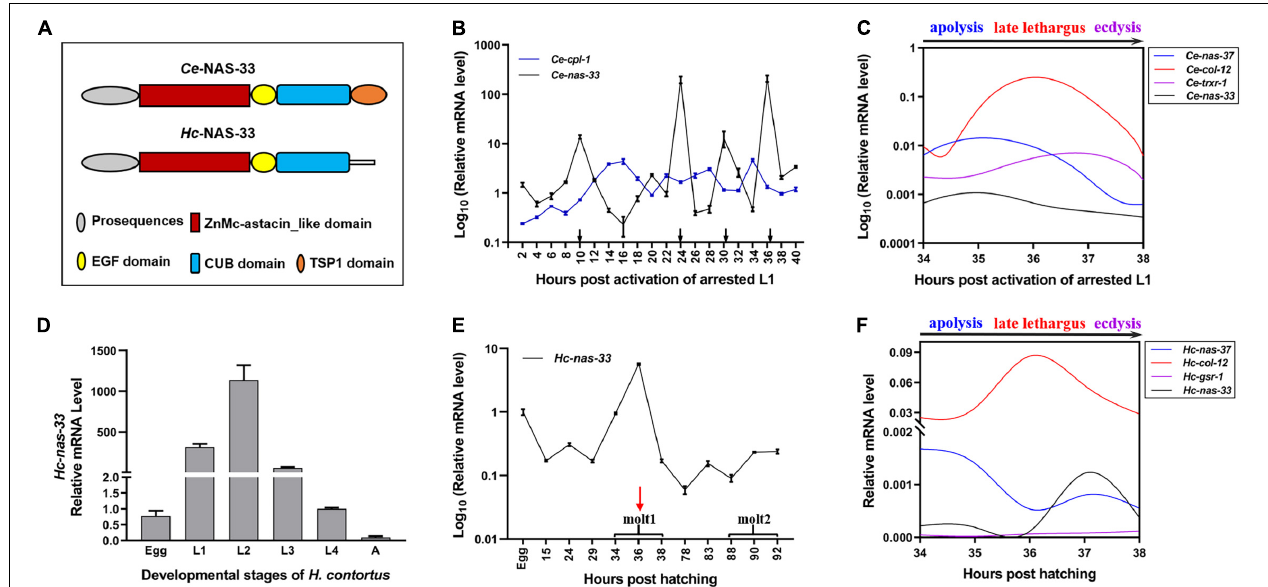
FIGURE 1 | Developmental transcription analysis of nas-33 in Caenorhabditis elegans and Haemonchus contortus . (A) Schematic diagram for domain architectures of Ce -NAS-33 and Hc -NAS-33. (B) Ce-nas-33 shows a tightly regulated transcriptional pattern across four molting periods (black arrows) of C. elegans . (C) Transcriptional alterations of marker genes nas-37 , col-12 , trxr-1 for apolysis, late lethargus and ecdysis, and nas-33 during the molting of C. elegans . (D) Transcription levels of Hc-nas-33 in different development stages of H. contortus . (E) Hc-nas-33 shows a transcriptional peak during the first molting of H. contortus . (F) Transcriptional alterations of marker genes nas-37 , col-12 , gsr-1 for apolysis, late lethargus and ecdysis, and nas-33 during the first molting of H. contortus . Error bars indicate mean ± standard deviation (SD). A Non-linear Curve Fit is performed to indicate the dynamic transcriptional changes of marker genes involved in the molting